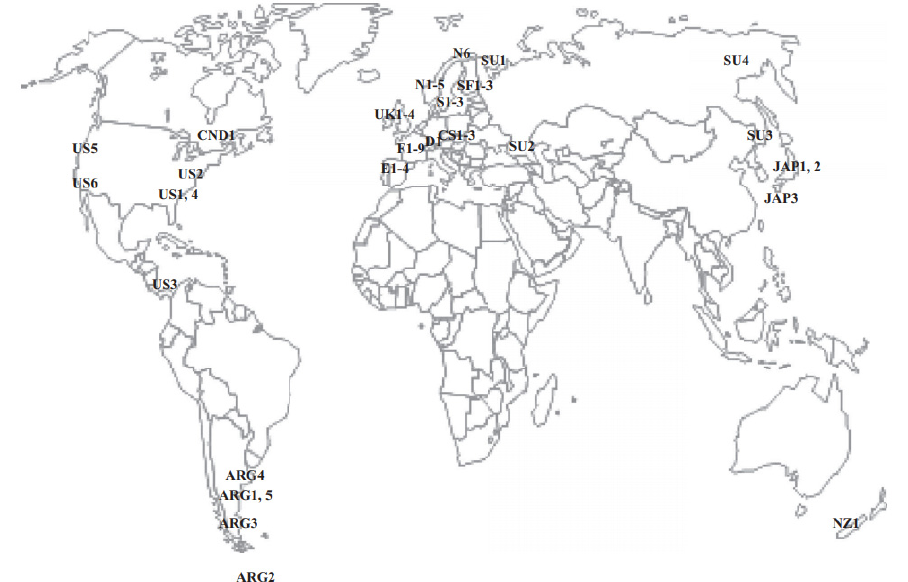
Figure 3. Geographic distribution of atmospheric exposure sites in the ISO-CORRAG program.